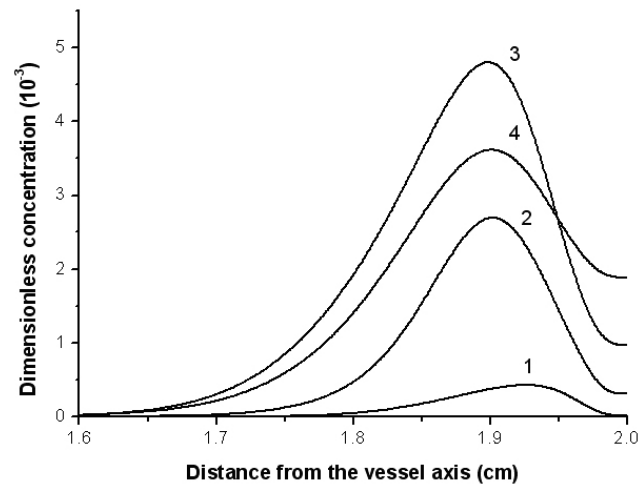
Figure 14. Numerical results on the distribution of the surfactant concentration in the bulk, 3 mm below the surface: 1 – t=t* + 2 s, 2 – t=t* + 17 s, 3 – t=t* +55 s, 3 – t=t* +2 min 19 s, t* – the time when the surface velocity has a maximum. The surfactant